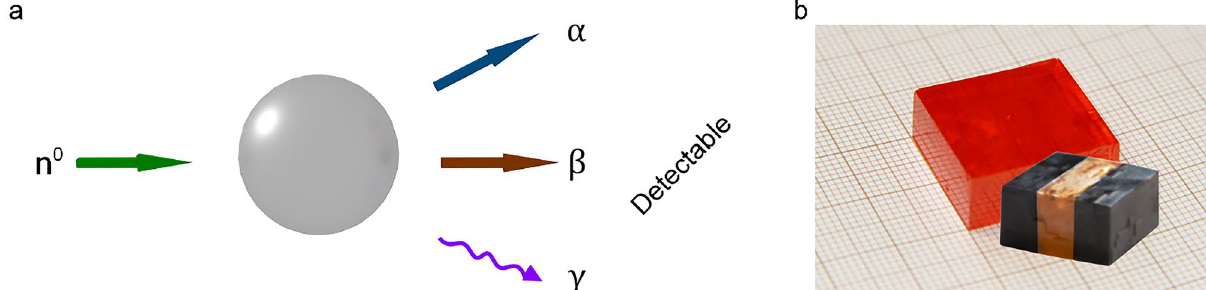
Figure 1. ( a ) Schematic representation of the principle of neutron radiation conversion into various forms of secondary radiation that can be more easily detected. ( b ) Photo showing two MAPbBr 3 SCs of relatively large volumes (~ 2 × 2 × 1 cm 3 ), one of which is equipped with graphite spray electrodes to work as a radiation